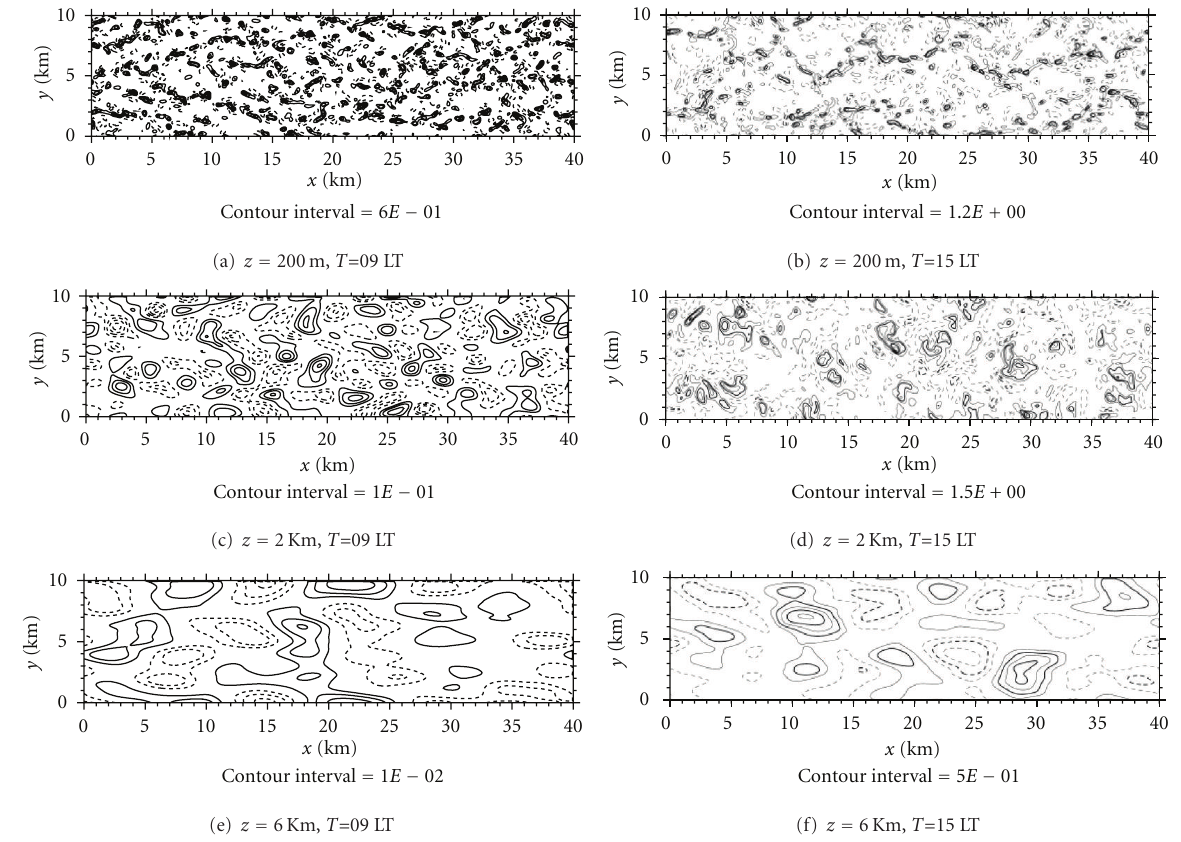
Figure 3: Horizontal cross-section of vertical velocity in the EXP1 case at 200 m height at (a) 0900 LT and at (b) 1500 LT, at 2km height at (c) 0900 LT and (d) 1500 LT, and at 6km height at (e) 0900 LT and at (f) 1500 LT. Contour intervals are indicated at the bottom of each panel. Positive (negative) values are indicated by solid (dashed) lines. The contour line of zero velocity is